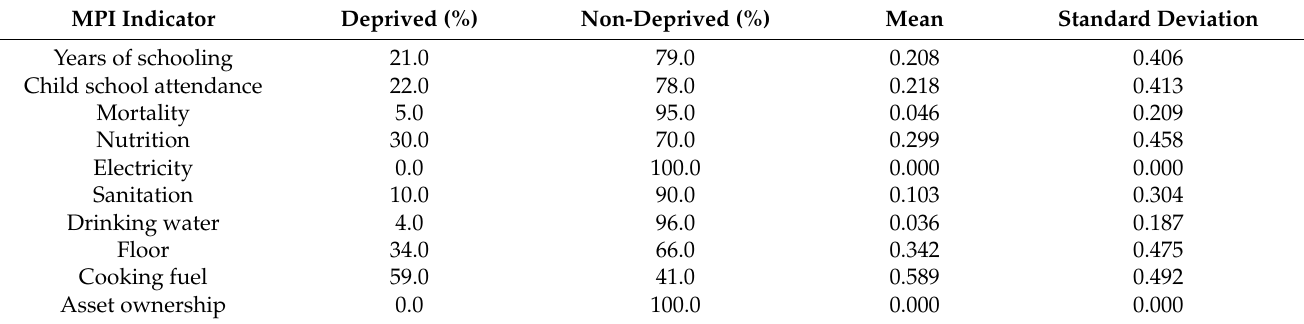
Table 4. Descriptive statistics of MPI